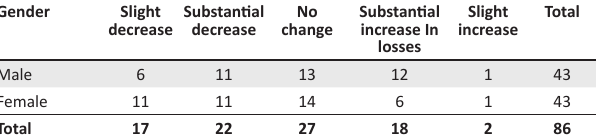
TABLE 11: Changes in disaster loss by gender.